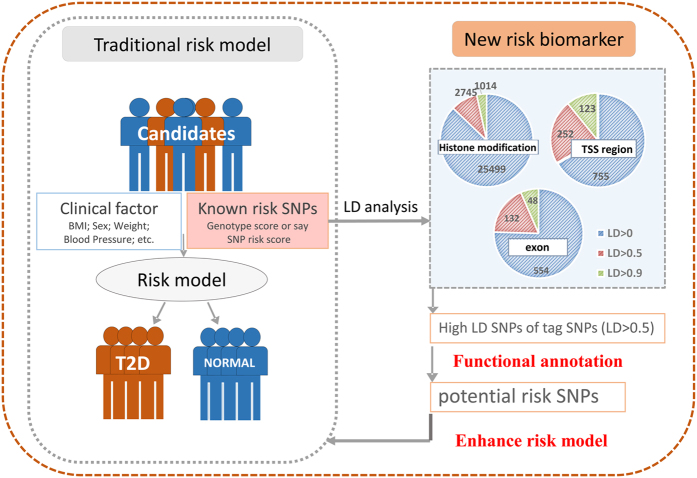
The flowchart of whole procedures, including FunciSNP results on 65 T2D related SNPs.Shown is the flowchart of present work. SNPs in linkage disequilibrium with 65 T2D risk SNPs were obtained by FunciSNP. Functional annotations were executed on high LD SNPs (r2 > 0.5) by integrating genomic, epigenetic and transcriptomic data. The putative risks result from annotations were employed for the improvement of risk model.